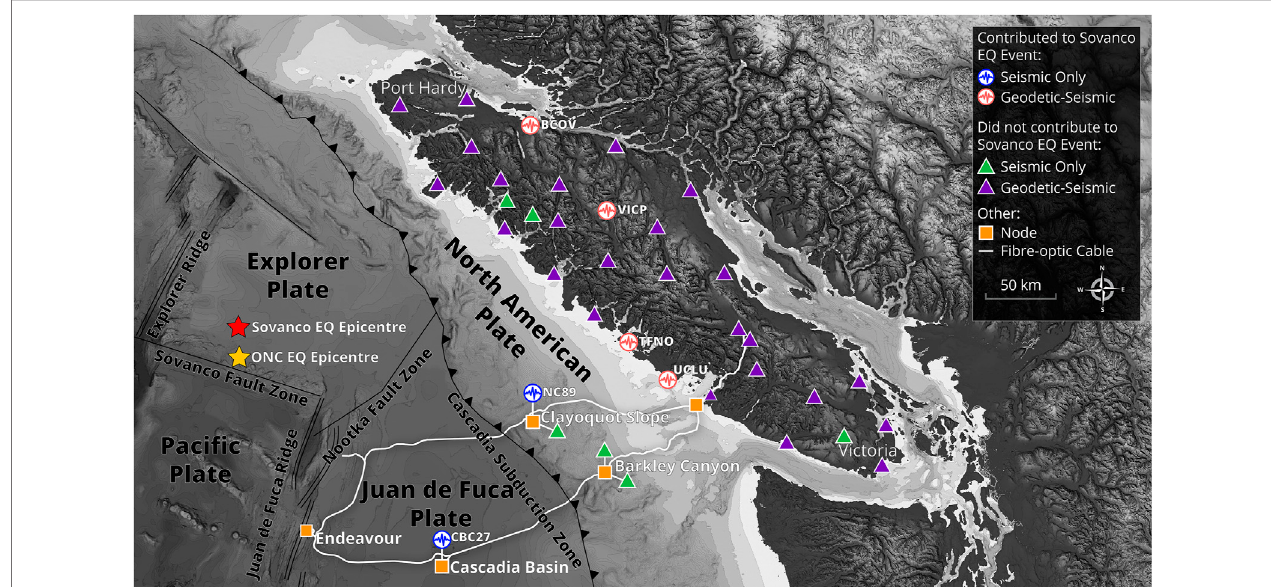
FIGURE1| OverviewmapofEEWsites.PurpletrianglesdisplaysitesthathavebothGNSSandseismicinstruments.Greentrianglesrepresentsitesthatonlyhave seismic instruments deployed. The red star marks the location of the M6.6 Sovanco earthquake from October 22, 2018 as identi fi ed in the NRCan earthquake catalog. The yellow star displays the location calculated by our EEW system for the same event (see Preliminary Results ). Circles with waveform symbols display the geographiclocationsofsitesthatcontributedtothe fi rstnoti fi cationofthiseventasdescribedin PreliminaryResults .Trianglesarestationsthatdidnotcontribute todetectionoftheSovancoearthquake.Datasources:PlatemarginboundariesareobtainedfromHyndmanandWang,1995.DigitalElevationmodelderivedfromRyan et al., 2009 NRCAN topography, and Canadian Hydrographic Service